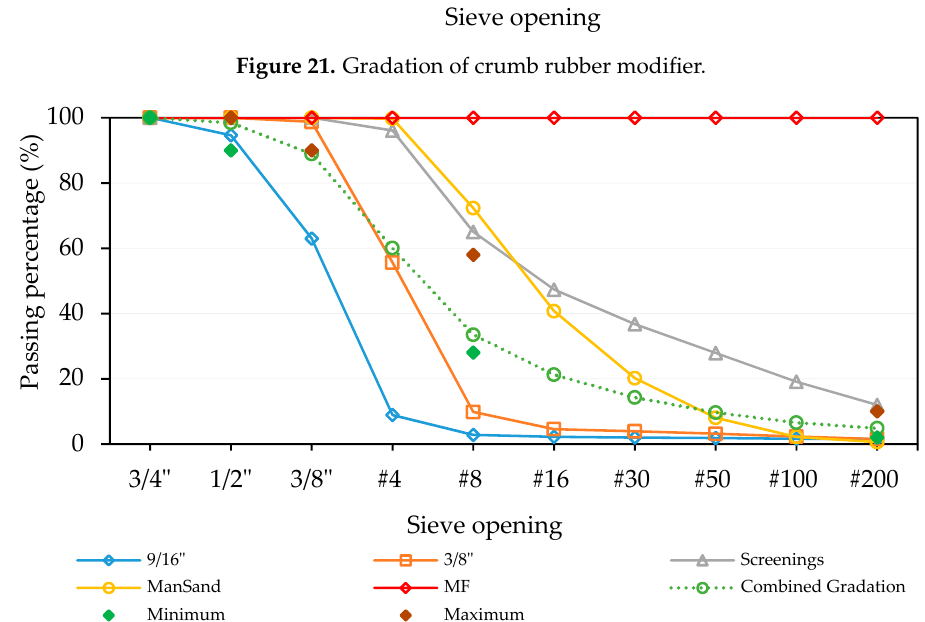
Figure 22. Gradation of aggregate, sand, MF and combined mix. Table 3. Properties of the aggregate.